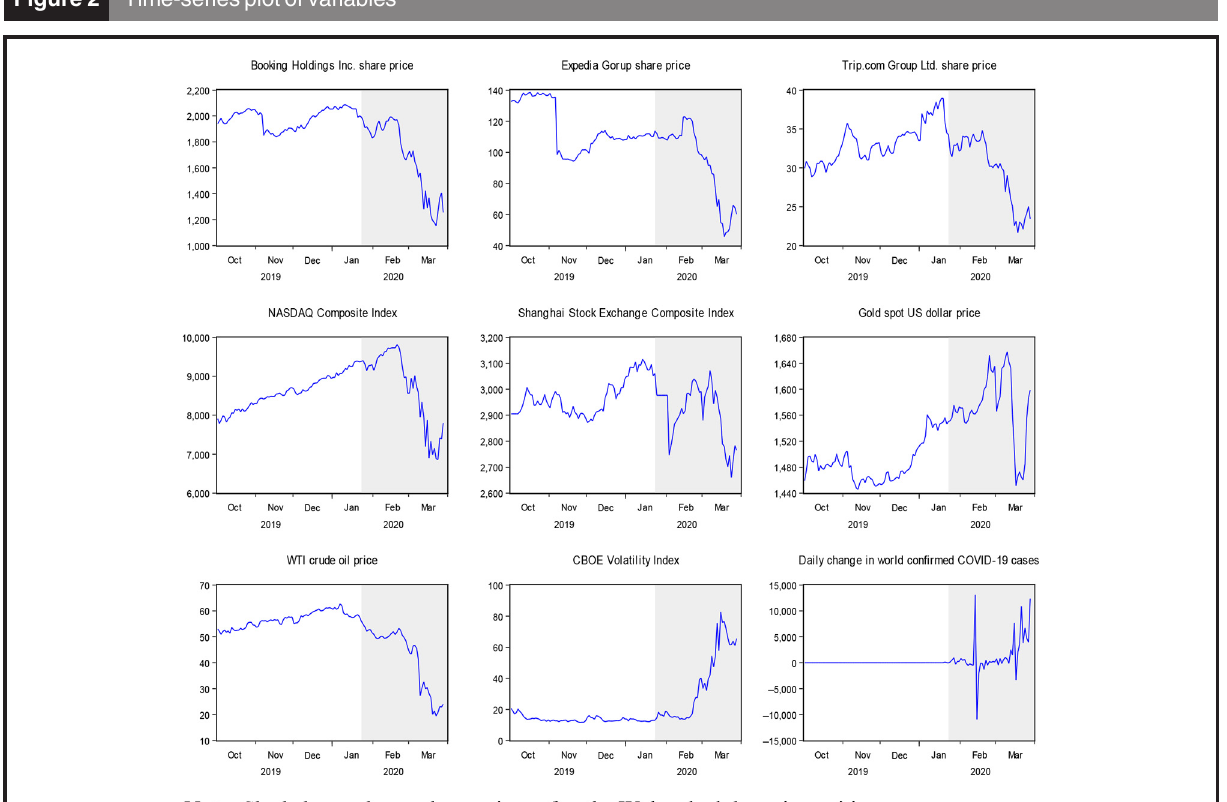
Figure 2 Time-series plot of variables